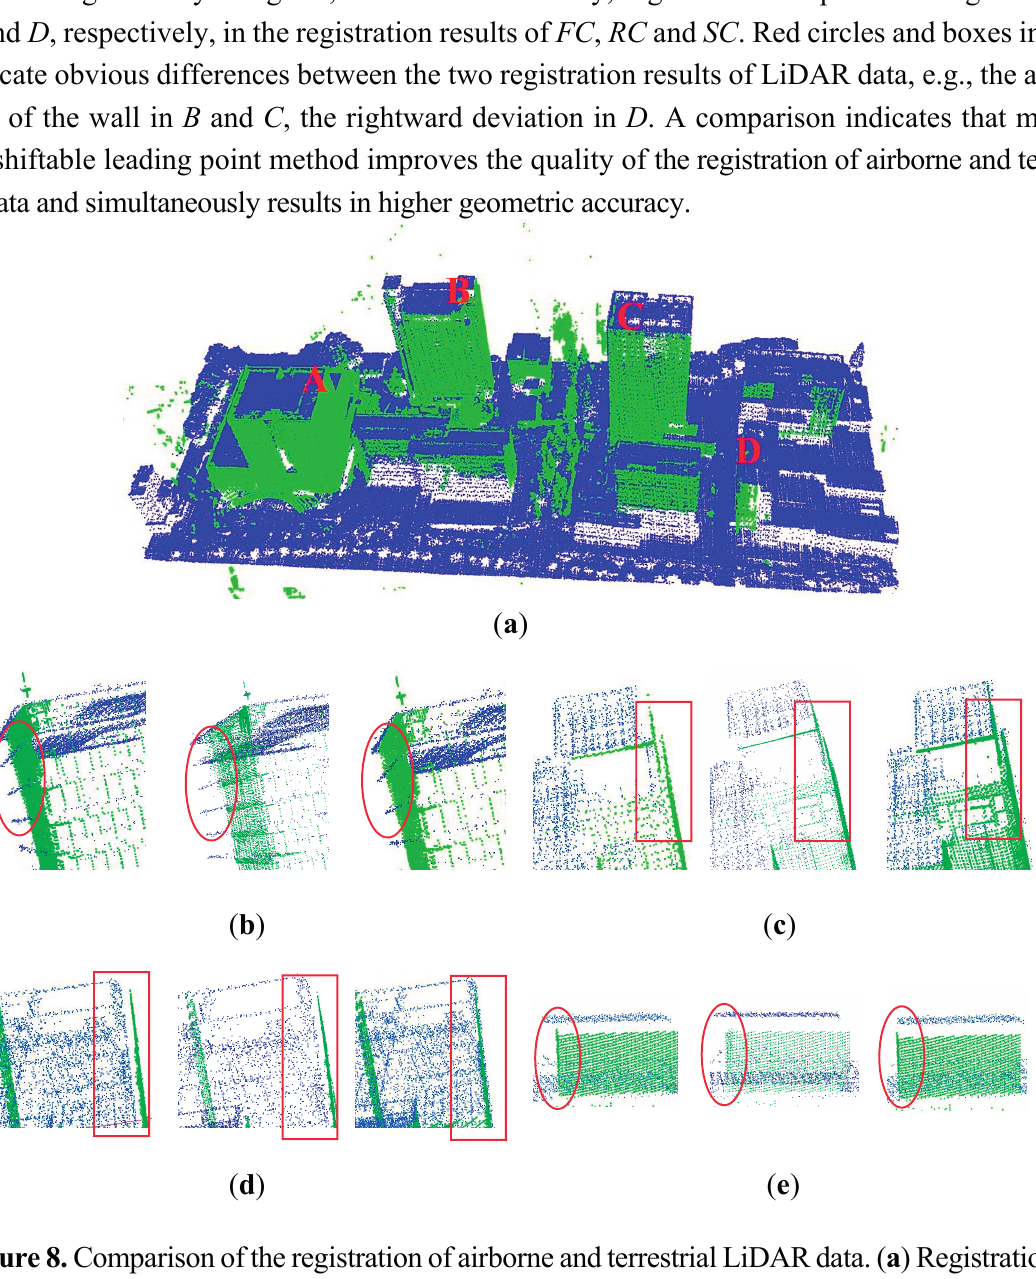
Figure 8. Comparison of the registration of airborne and terrestrial LiDAR data. ( a ) Registration results by using SC ; ( b – e ) differences of Labels A , B , C and D ,